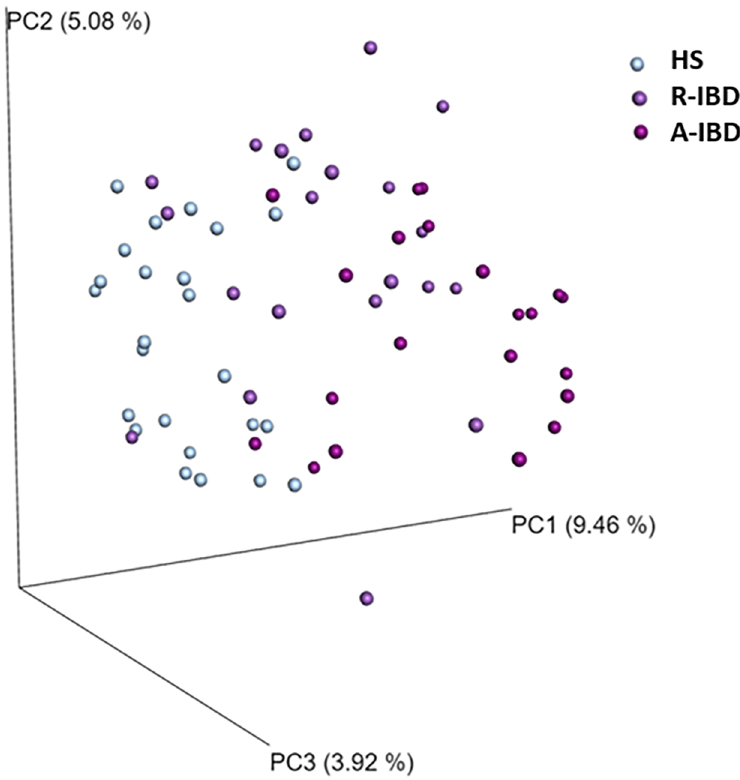
Fig 5. Beta diversity according to Bray Curtis index between healthy subjects (HS) and IBD in remission (R-IBD) and in flare (A-IBD).